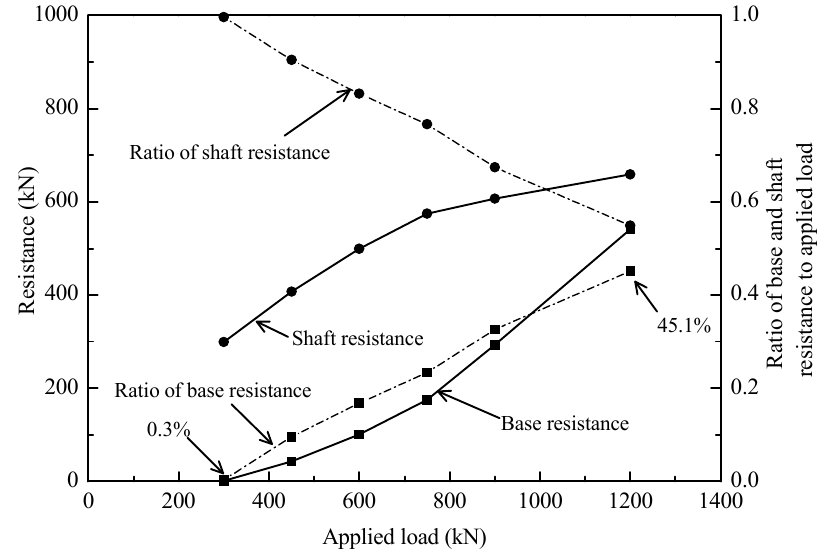
Figure 15. Variation of base and shaft resistance during loading test.